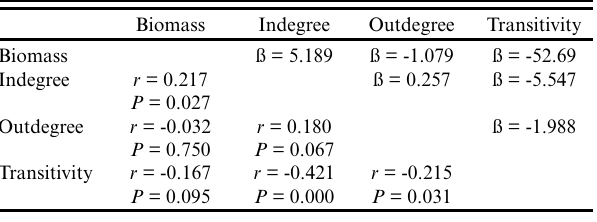
Table 4 . Pearson correlation coefficients ( r ) and respective P values are presented for each pair of variables (biomass, indegree, outdegree, and transitivity) below the diagonal. Ordinary least squares regression slopes are presented above the diagonal. The betas represent the change in the variable indicated in the first column of the table that corresponds to a unit change of the respective variable indicated in the top row of the table. The P values associated with the regression coefficients are identical to the correlation P values below the